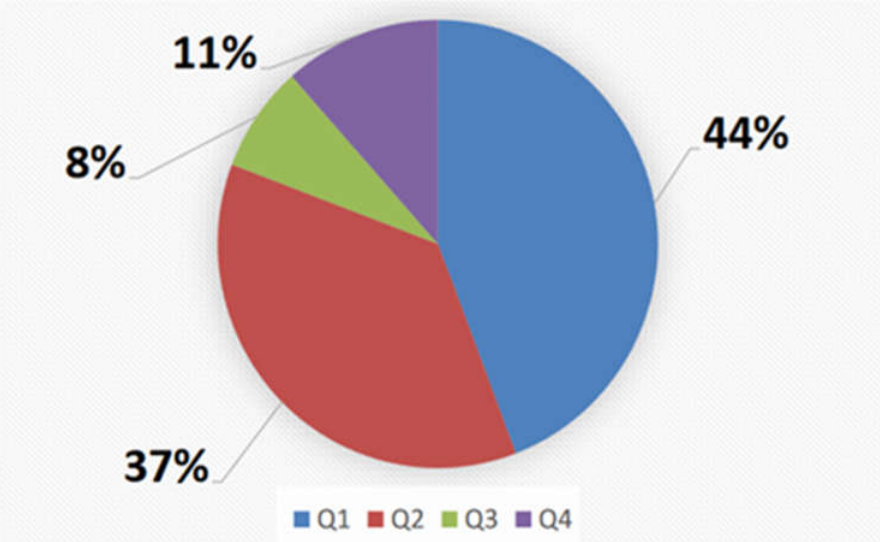
Figure 3. Quartile analysis